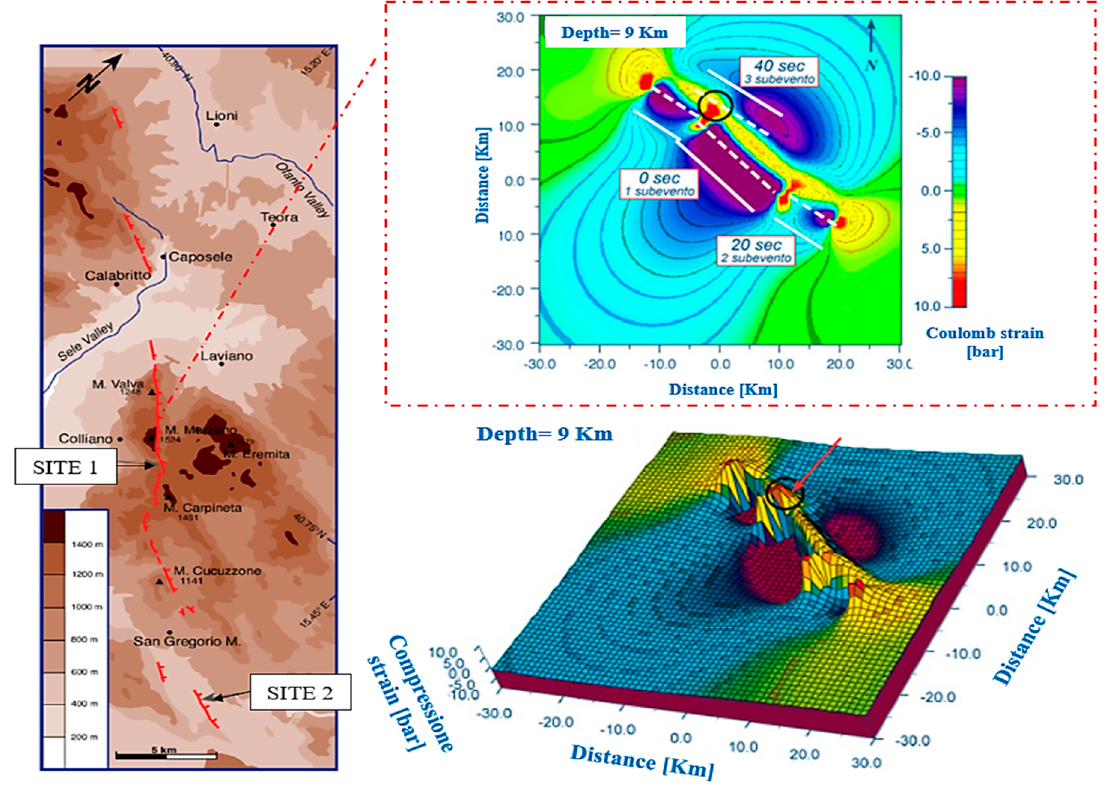
Figure 3. The fault mechanisms that occurred in the 1980 Irpinia earthquake.